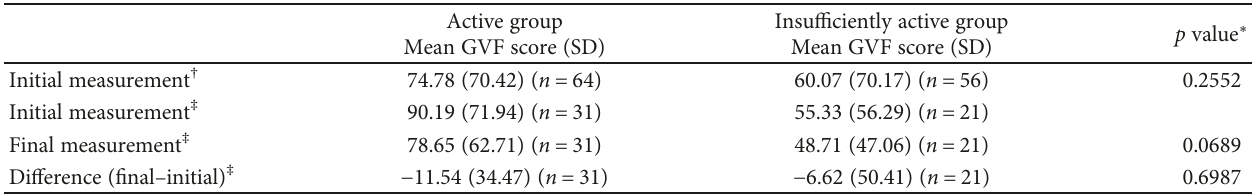
Table 3: Relationship between Goldmann visual fi eld scores and exercise levels.